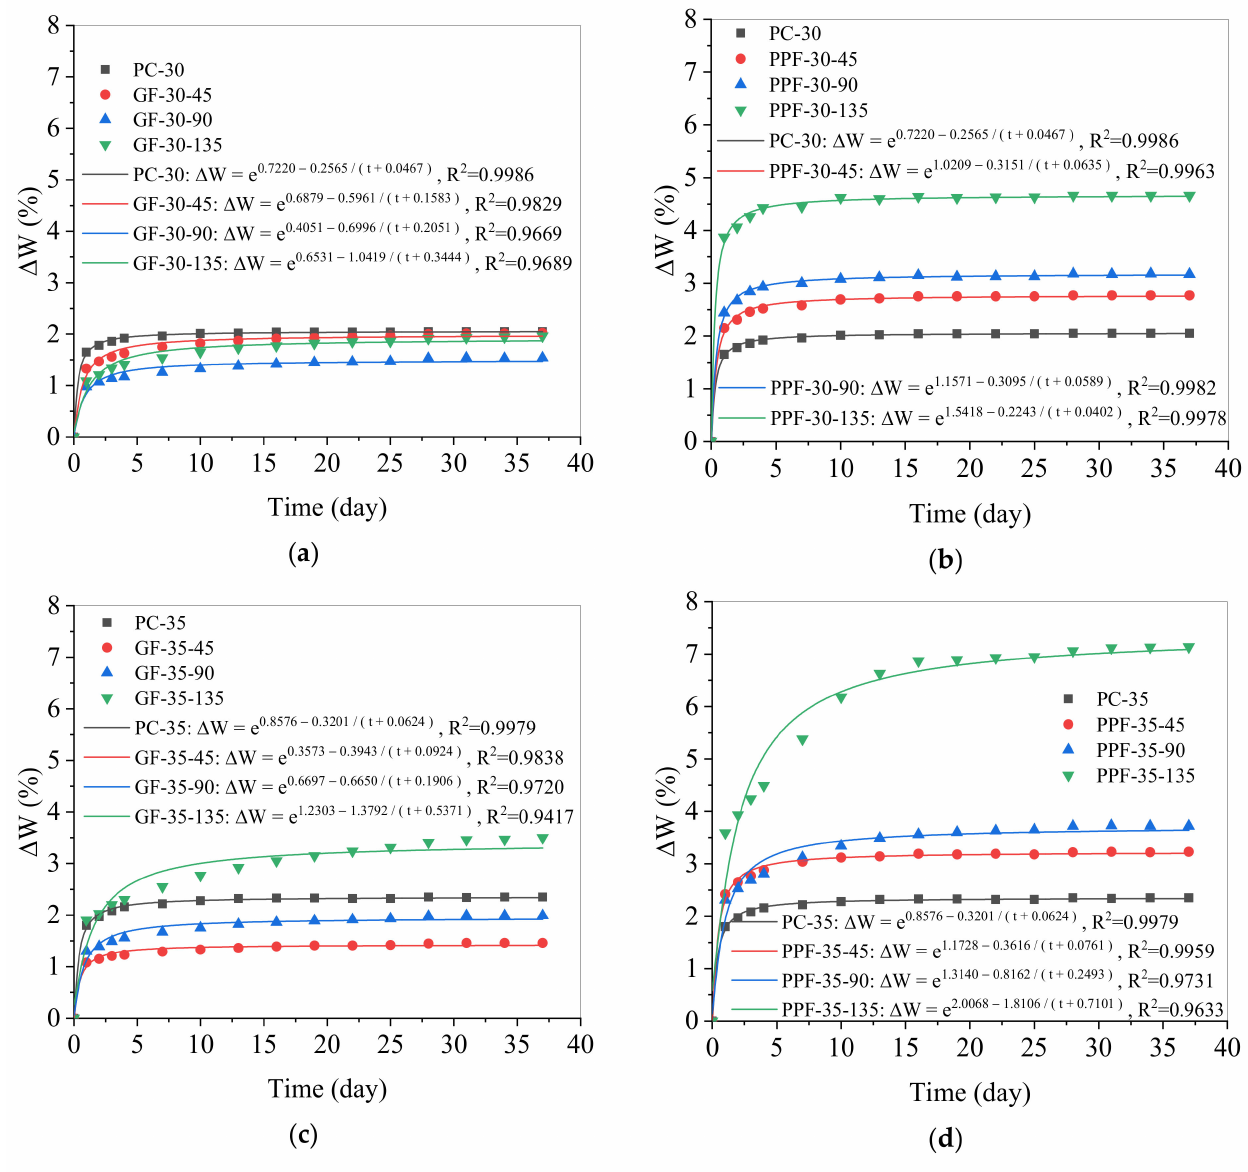
Figure 7. The fitting curves of the water absorption of concrete after curing for three years: ( a ) Fitting curve of the water absorption of the GFRC when w/b = 0.30; ( b ) Fitting curve of the water absorption of the PPFRC when w/b = 0.30; ( c ) Fitting curve of the water absorption of the GFRC when w/b = 0.35; ( d ) Fitting curve of the water absorption of the PPFRC when w/b =